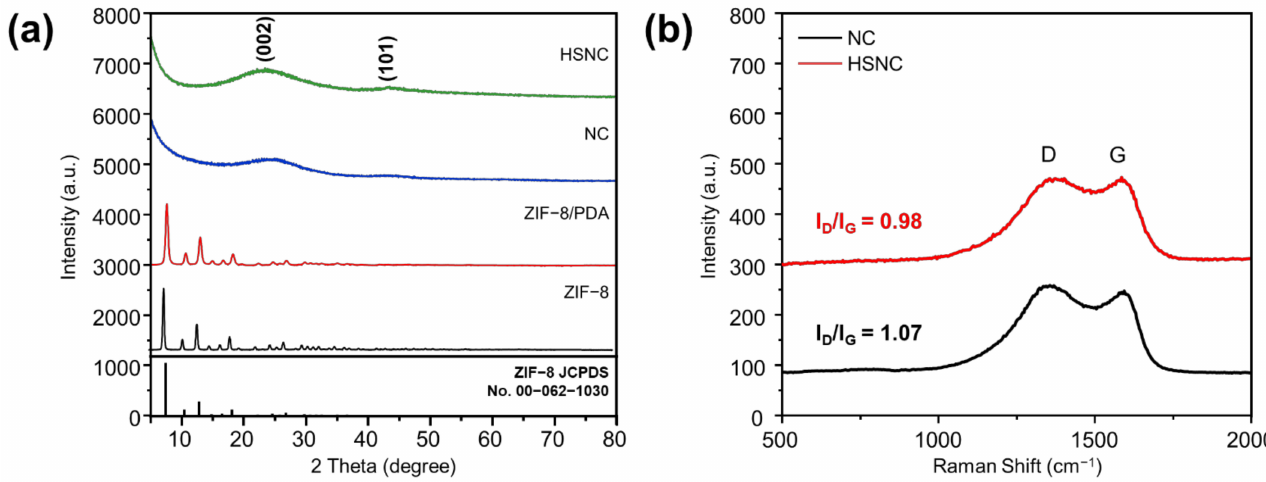
Figure 2. ( a ) XRD of ZIF-8/PDA, HSNC, and NC derived from ZIF-8; ( b ) Raman spectra of NC derived from ZIF-8 and